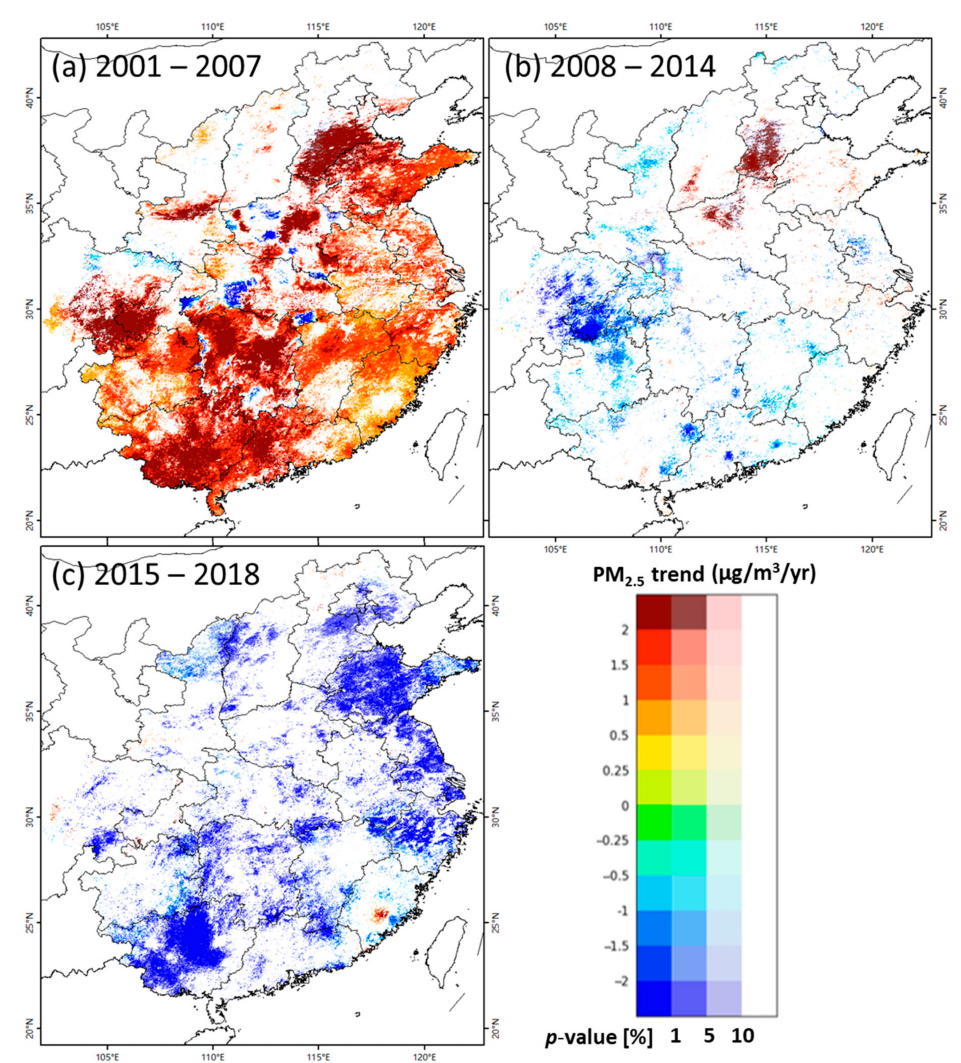
Figure A6. Spatial distribution of linear trends in monthly time series PM 2.5 anomaly from ( a ) 2001– 2007, ( b ) 2008–2014, and ( c ) 2015–2018 periods using the generalized least-squares regression. Warm and cold color represents positive and negative trends, respectively; the transparency of colors represents the statistical p -value of trends.